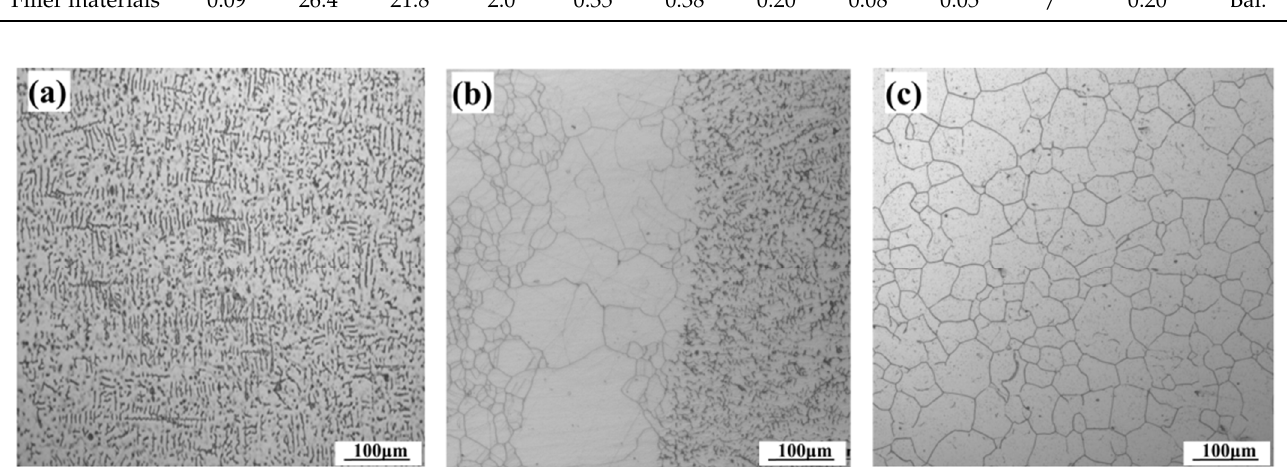
Figure 1. Metallographic morphology of 310S stainless steel welded joints ( a ) WM ( b ) HAZ and ( c ) BM.